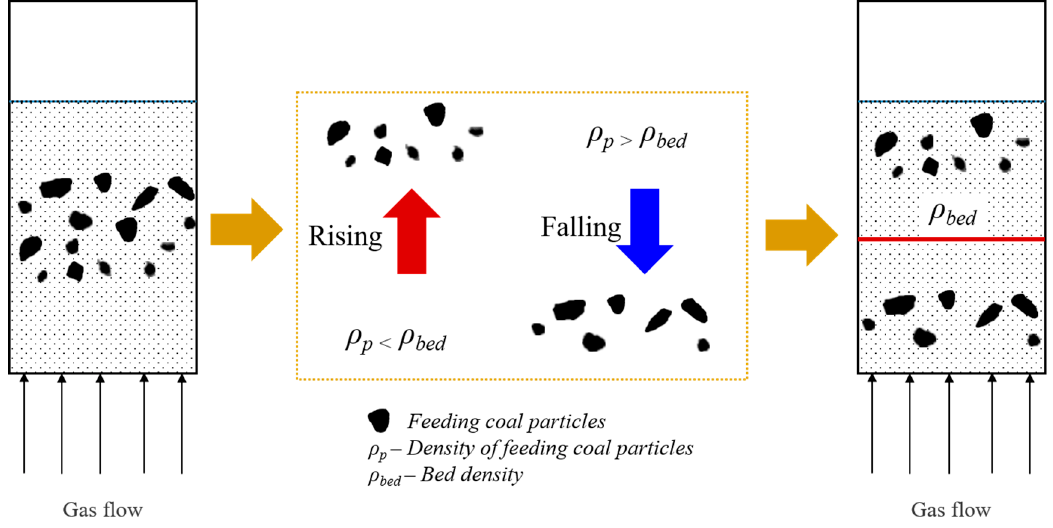
Figure 10. Fluidized bed separation process based on bed density.